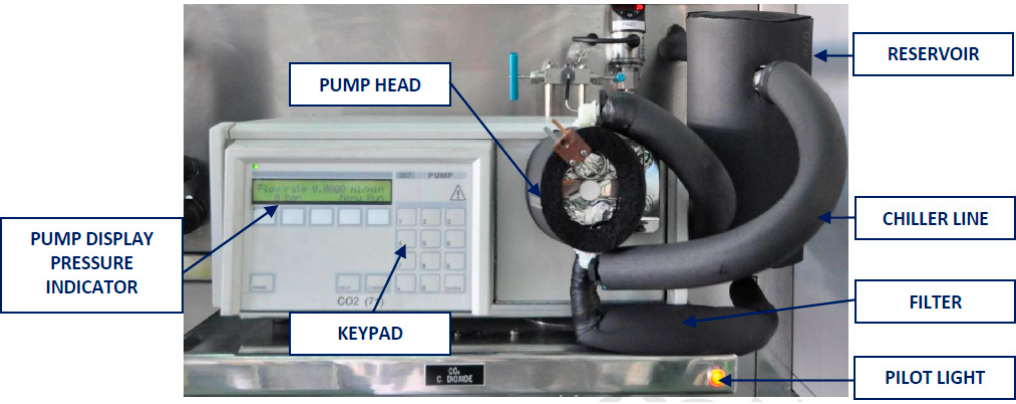
Figure 4. Carbon dioxide HPLC pump; one of the four pumps used to inject liquids in the reactors.